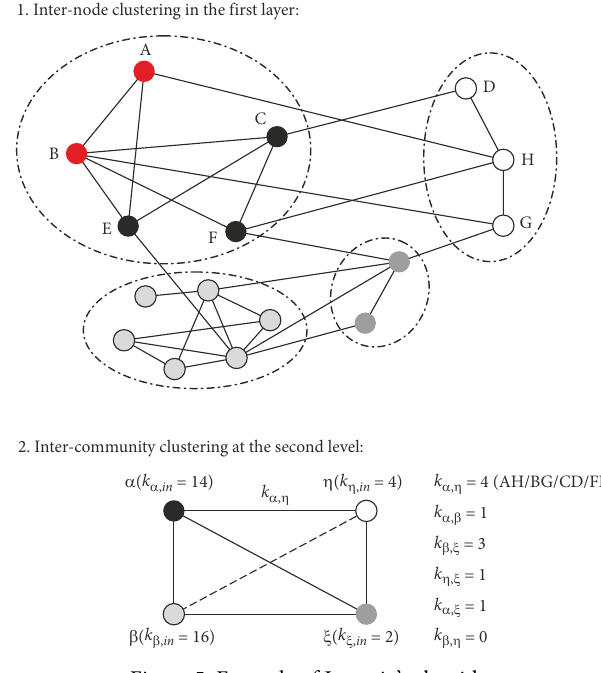
Figure 5. Example of Louvain’s